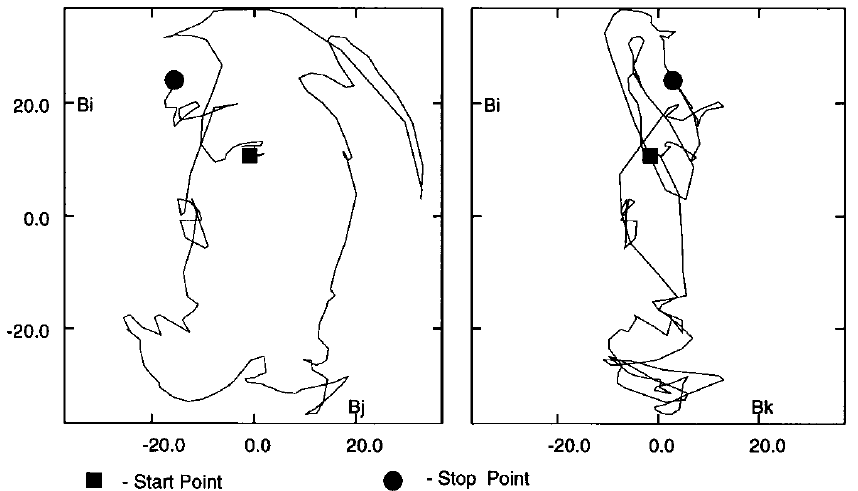
Fig. 4b. Magnetic field hodogram of the Polar vortex-like structure in the main MP current sheet on 29 May 1996 at 07:00:43–07:00:52UT. The maximum, medium and minimum variance eigen values and eigen vectors in the SM coordinate system are: Ai = 505 . 9 ,ei = ( 0 . 39 ;− 0 . 46 ; 0 . 8 ) ; Aj = 204 . 4 ,ej = ( 0 . 14 ;− 0 . 83 ;− . 0 . 55 ) ; Ak = 28 ,ek = ( 0 . 91 ; 0 . 33 ;− 0 . 26 ) .